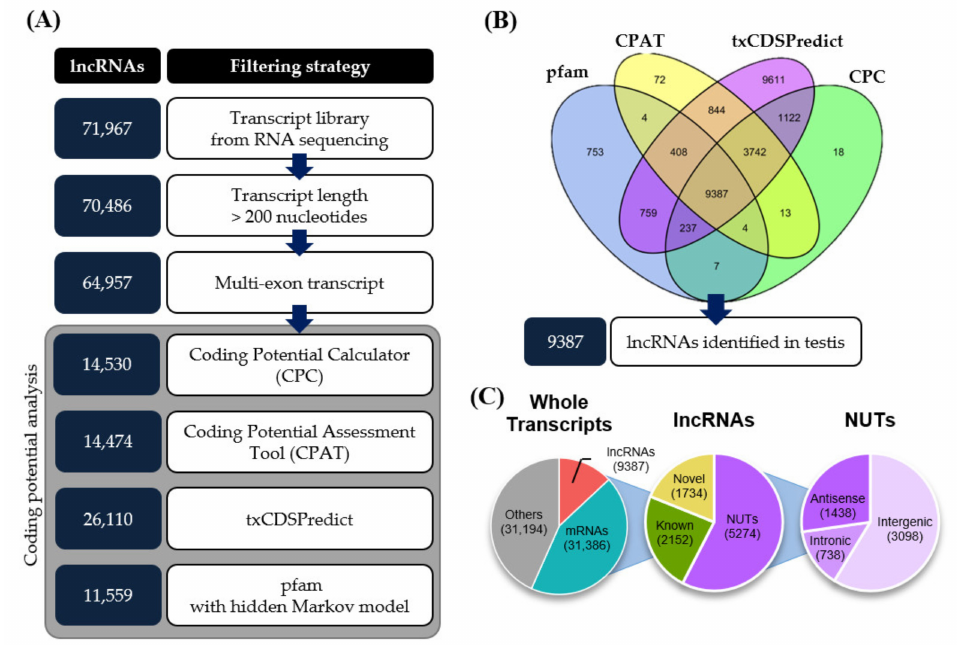
Figure 1. Pipeline for identifying testis-expressed lncRNAs from total RNA sequencing data by in silico analysis. ( A ) Filtering strategy for identifying lncRNAs from total RNA sequencing data. ( B ) Intersection of coding potential analysis tools (CPC, CPAT, txCDSPredict, and pfam with hid- den Markov model). ( C ) Genome-wide composition of transcripts identified in aged mouse testis using the following class codes from CuffCompare. “Others” represents ncRNAs with single-exon sequences and sequences shorter than 200